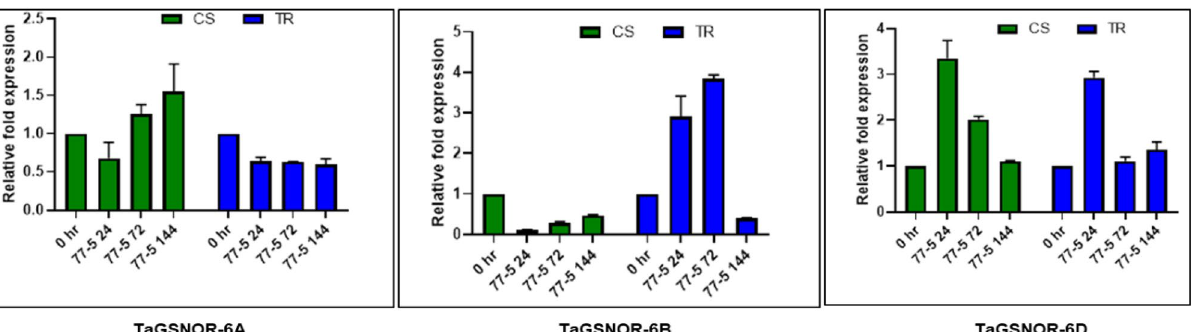
Figure 7. Expression analysis of TaGSNOR genes in leaves of wheat genotypes Chinese spring (CS) (susceptible) and transfer (TR) (resistant line) inoculated with leaf rust pathotype 77-5. Samples were collected at different time intervals viz., 0 h after inoculation (HAI), 24HAI, 72HAI and 144HAI. Values are means (± SE) of 3 biological replicates. Graphs were created in Graph Pad prism 8 (www. graph pad. Expression of TaNIA1 , TaNIA2, and TaNIA3 was up-regulated to the maximum level at 24 h after inoculation. When we compared the relative fold expression, the TaNIA1 gene showed maximum up-regulation (approx. 250fold) at 24HAI, followed by a steady decrease in expression at other time points. Expression of TaNIA4 , TaNIA6, and TaNIA7 was up-regulated at both 24HAI and 72HAI; however, maximum up-regulation occurred after 72HAI. TaNIA7 and TaNIA8 showed another distinct pattern in gene expression. In both, these genes expression was conspicuously up-regulated at 72HAI only (Fig. 6). Expression of TaGSNOR1 showed no or neg- ligible changes in expression w.r.t treatments. Whereas TaGSNOR2 was highly up-regulated by leaf rust patho- gen, 24 and 72 h after inoculation, followed by a sharp decrease in expression at 144 h of inoculation (Fig. 7). Visualization of NO using fluorescent microscope. Based on the previous reports 49 72HAI was selected to study NO localization. After inoculation with pathotype 77–5, the leaves of the two combinations were sampled at 72 h after inoculation for NO labelling, and the results are shown in Fig. 8. Green fluorescence could be observed in stomatal guard cells for compatible and incompatible combinations, indicating that trace